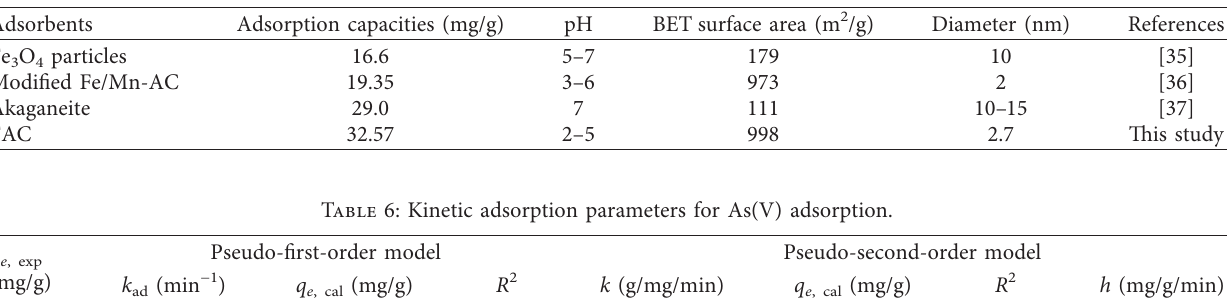
Table 5: The comparison of adsorption capacities of As(V) onto FAC and other adsorbents